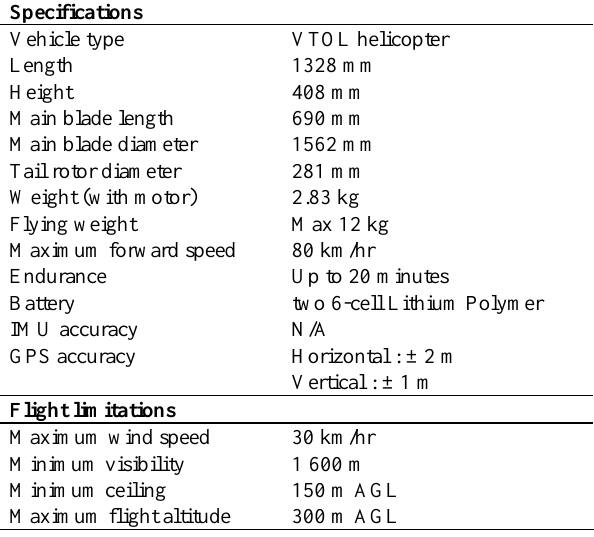
canadensis ), Orange enclosure : fallow deer ( Dama dama ) and Purple enclosure : grey wolves ( Canis lupus ). Flight lines (FL; red lines), ground targets ( ) and observers (binocular symbol) are indicated.